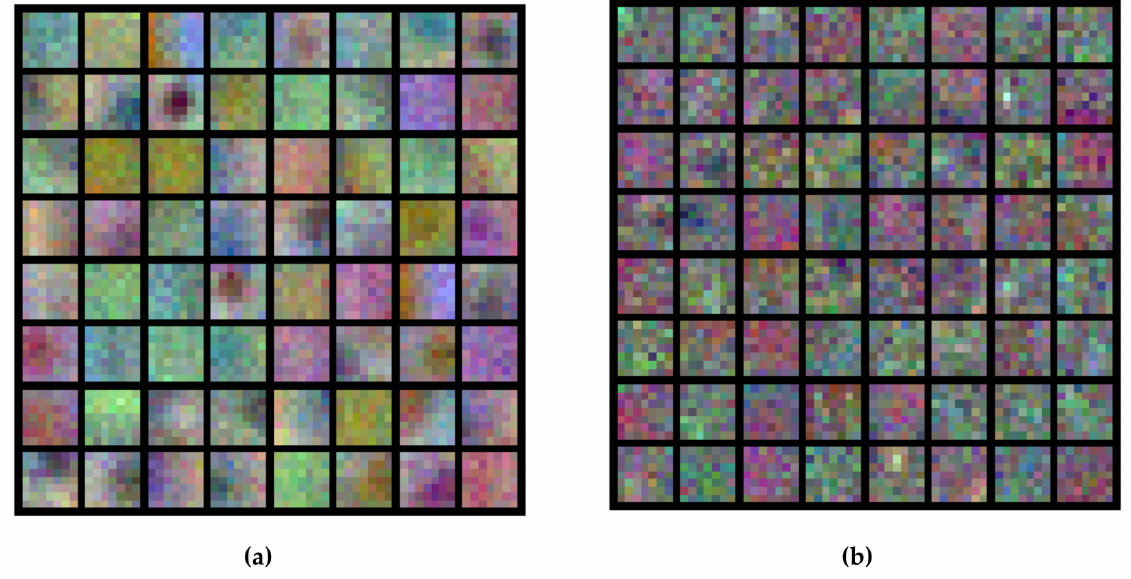
Figure 12. Weights for the first convolutional layer for ResNet18 used for the classification of the thin-section dataset: ( a ) ResNet18 trained on RawFooT; ( b ) same weights after the model is fine-tuned on the thin-section